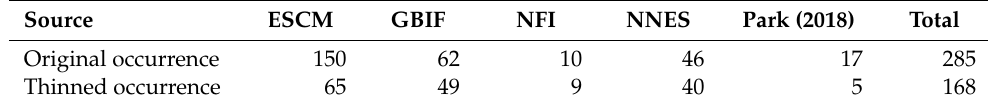
Table 1. Sources and number of occurrence data for Angelica gigas in South Korea.